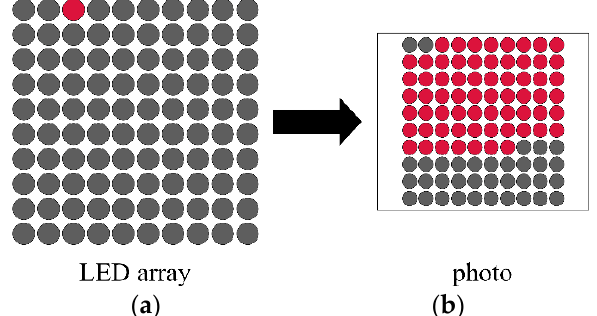
Figure 14. Measuring exposure time with a running LED on an LED array. ( a ) One LED is on at a time ( b ) On the exposed image multiple LEDs are bright.